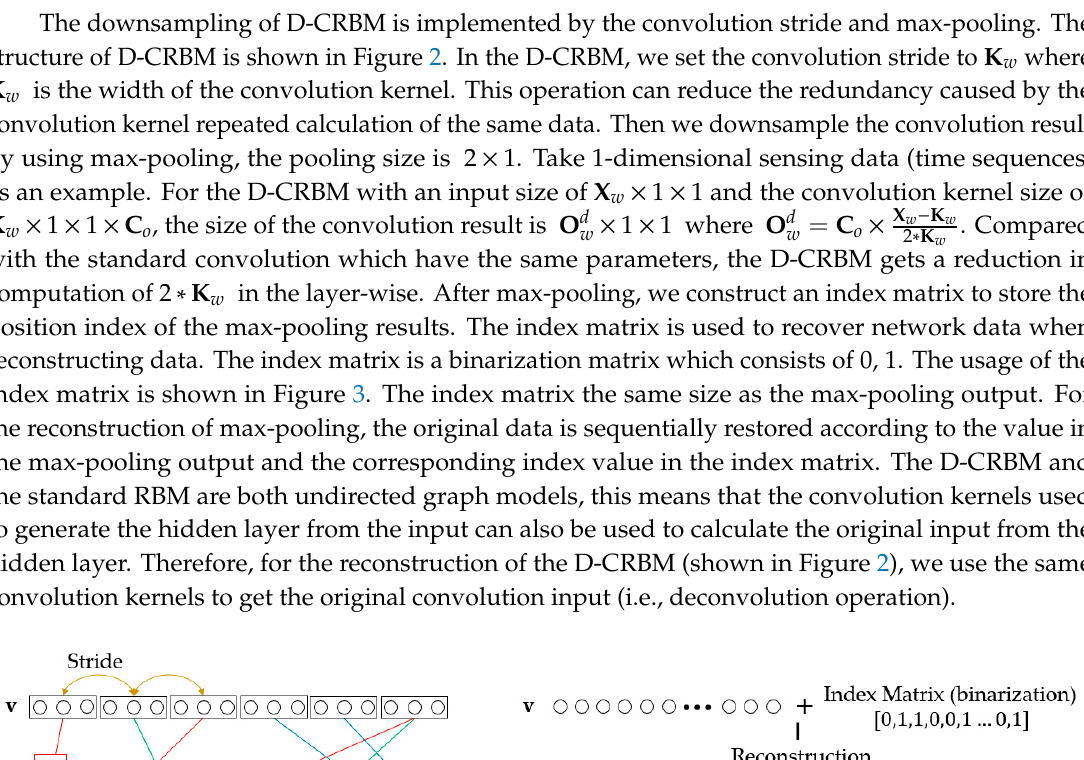
Figure 1. Convolutional Restricted Boltzmann Machine (CRBM).